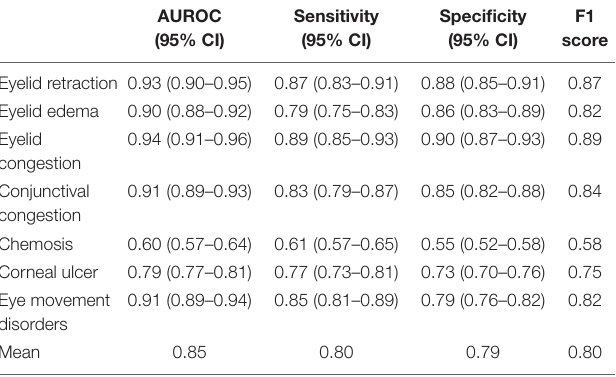
TABLE 4 | Diagnostic